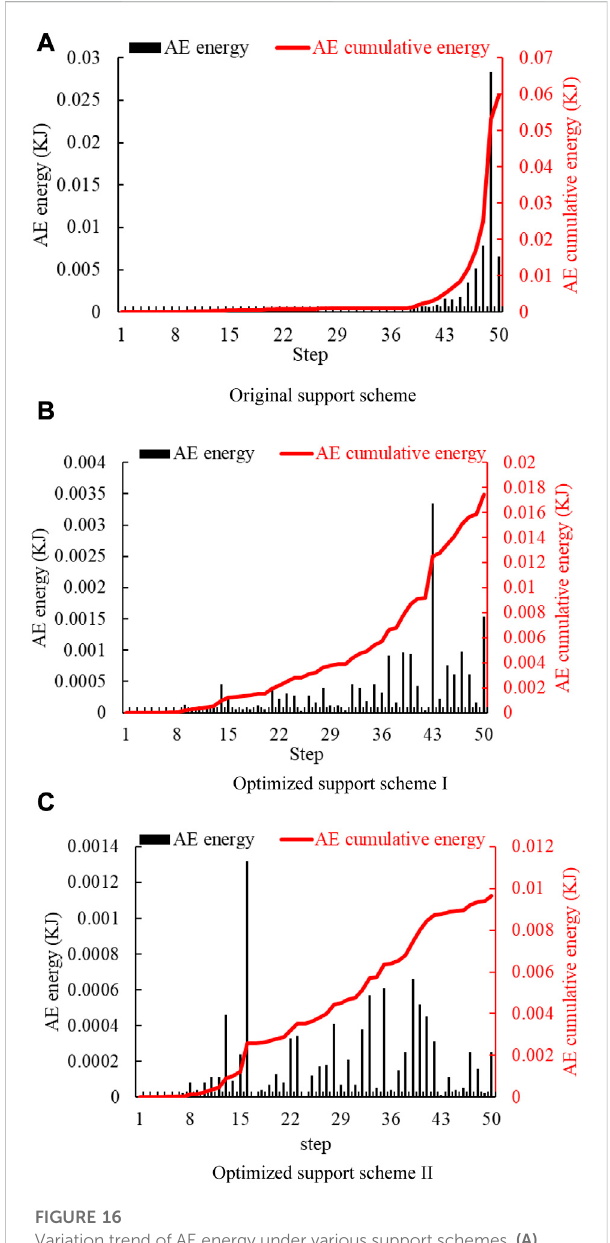
FIGURE 16 Variation trend of AE energy under various support schemes. (A)